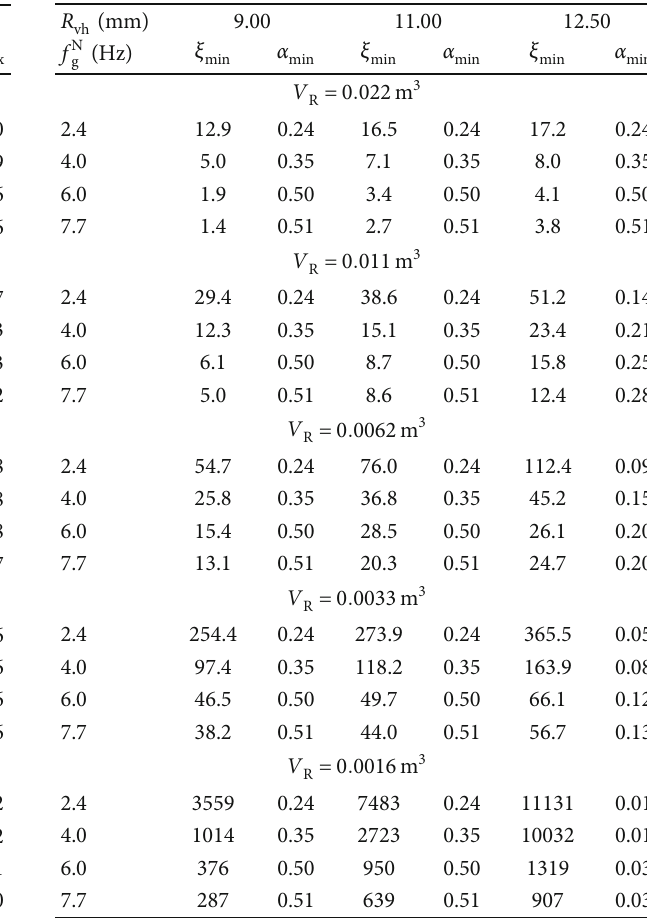
Table 4: Positive pressure jumps. Values of the total pressure loss Table 5: Negative pressure jumps. Values of the total pressure coe ffi cient, ξ , and fl ow coe ffi cient, α , as a function of the max max nominal gust frequency, f N , and vent hole radius R = 9 , 11, and vh g